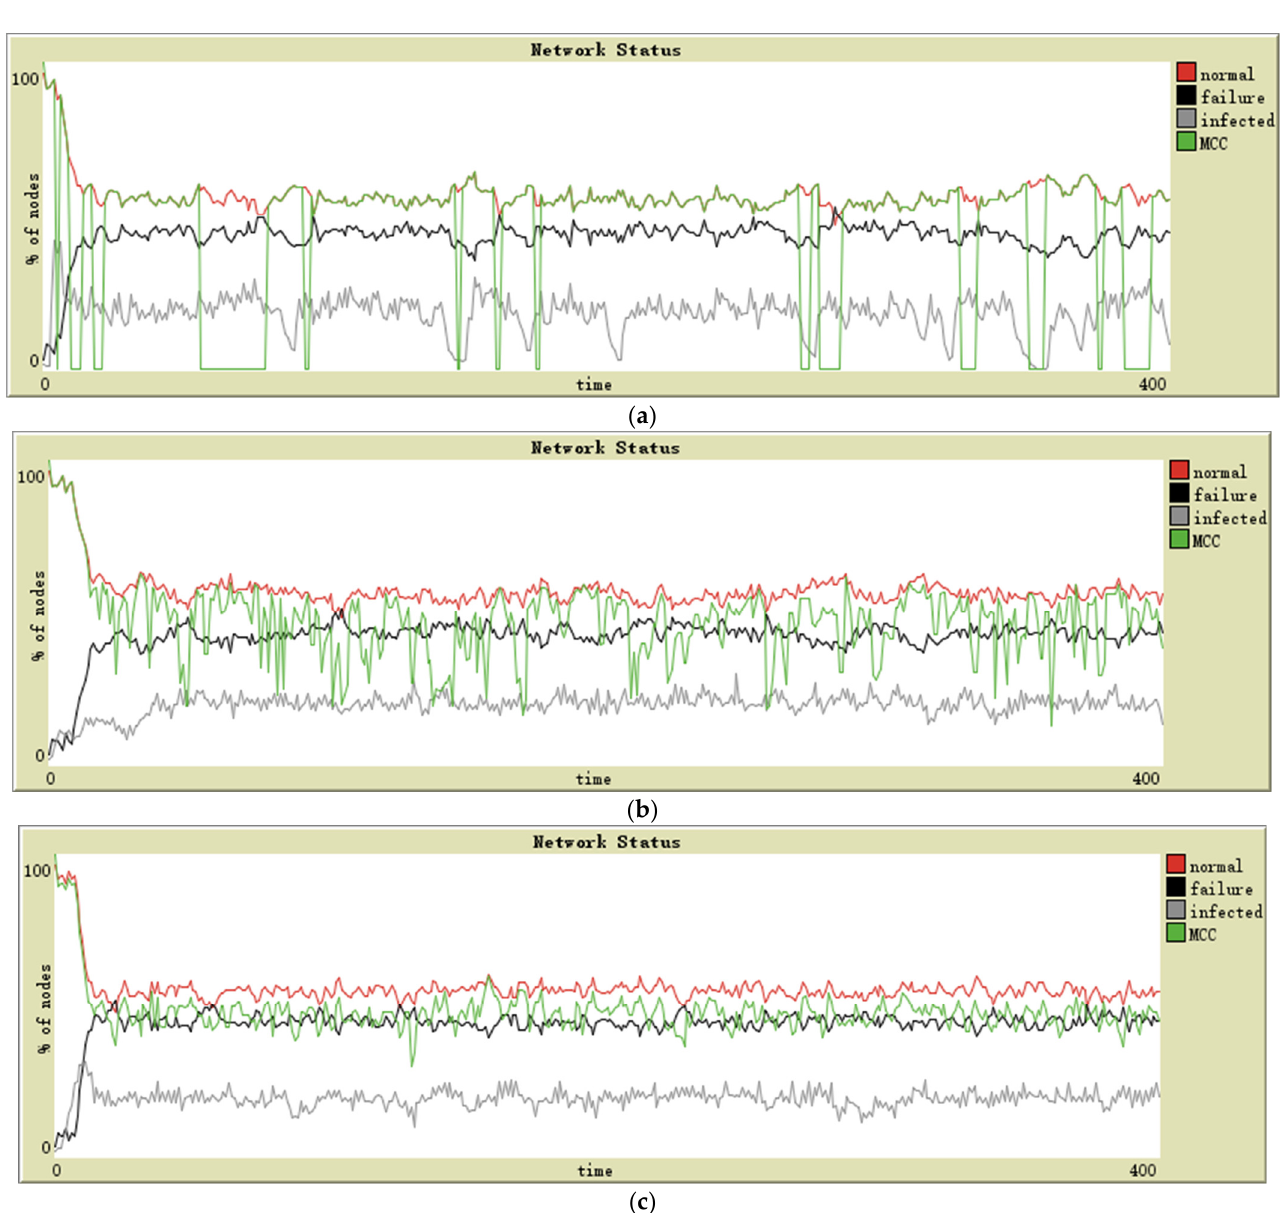
Figure 4. Simulation on industry application in ( a ) star topology, ( b ) lattice-2d topology, and ( c ) random topology.